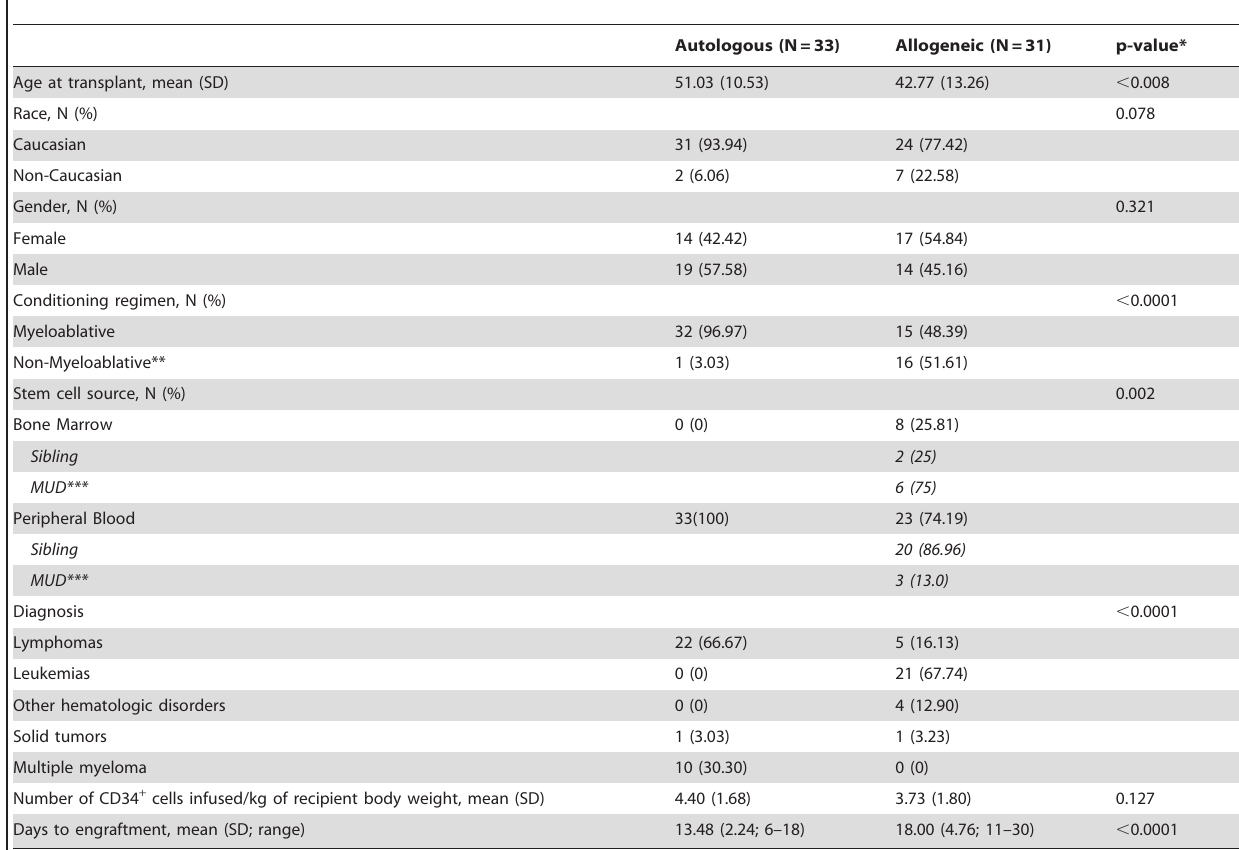
Table 1. Participant characteristics,